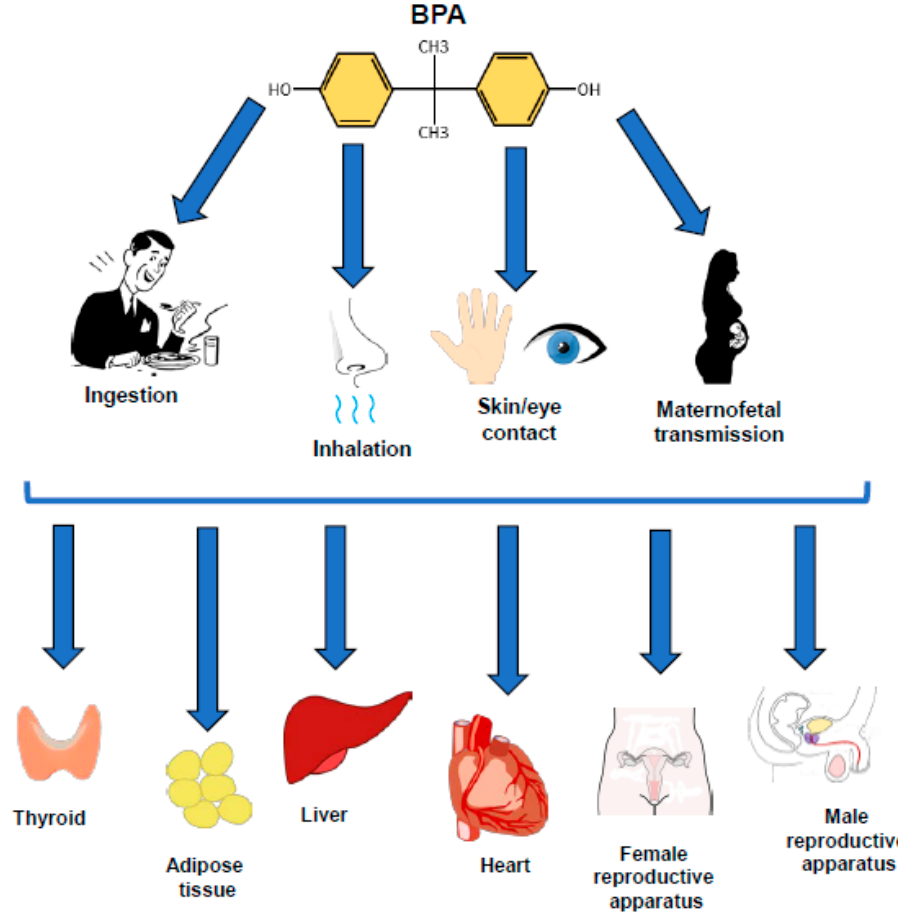
Figure 1. Potential BPA source and targets. BPA exposure sources include ingestion, maternofetal transmission, inhalation, skin, and eye contact. Once in the human body, BPA can negatively affect several targets, such as the thyroid, adipose tissue, liver, heart, female, and male reproductive apparatus. Images used to schematically represent anatomic parts and physiologic events were derived from openclipart.org and publicdomainvectors.org.